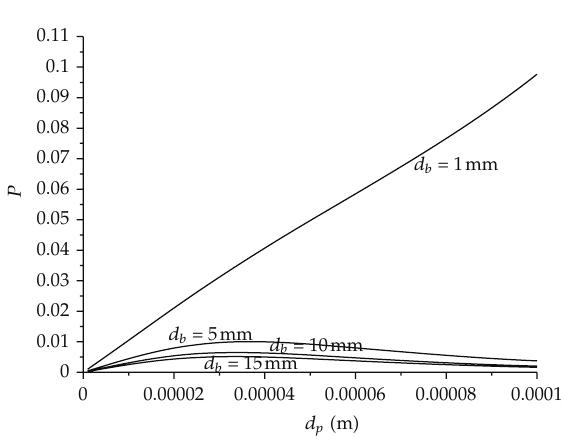
Figure 4: Collection